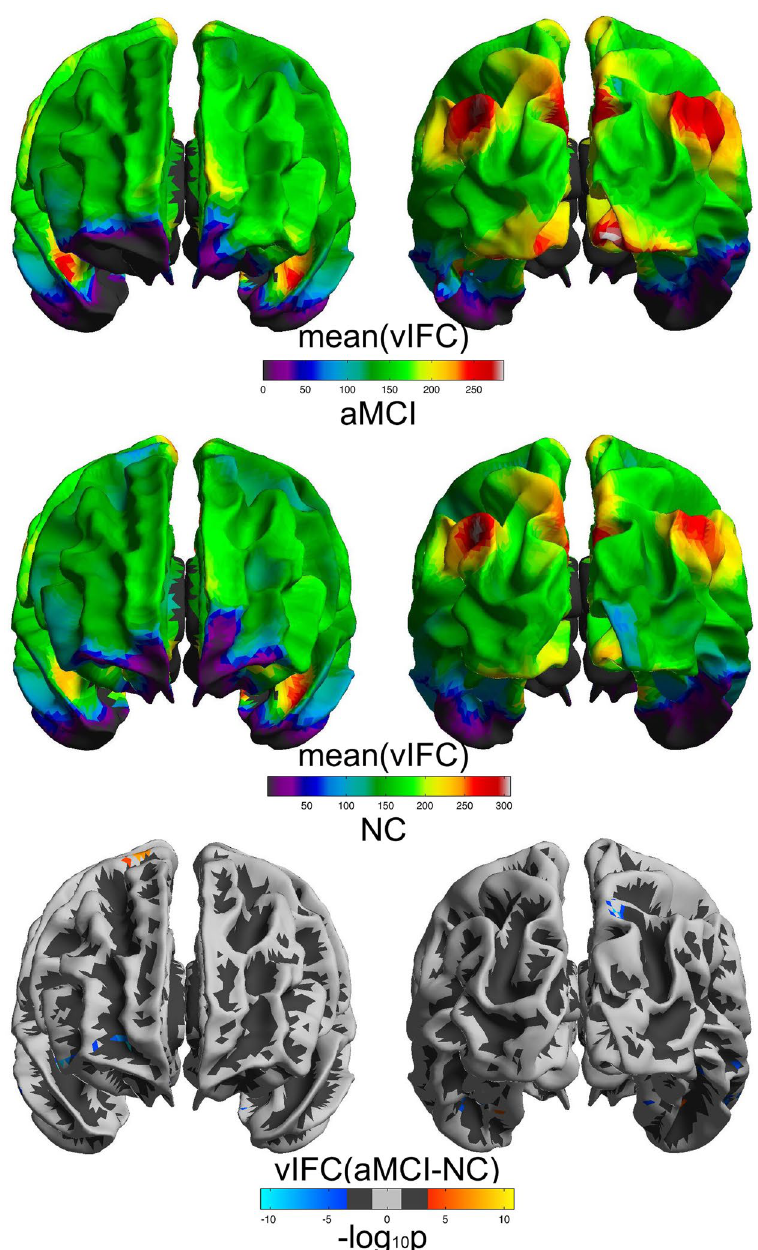
Figure 3. Significant aMCI-NC differences in vIFC across cortical mantle. The cold and warm colors respectively stand for significant decreased and increased vIFC compared to normal controls (FDR α < 0.05/2, corrected p <